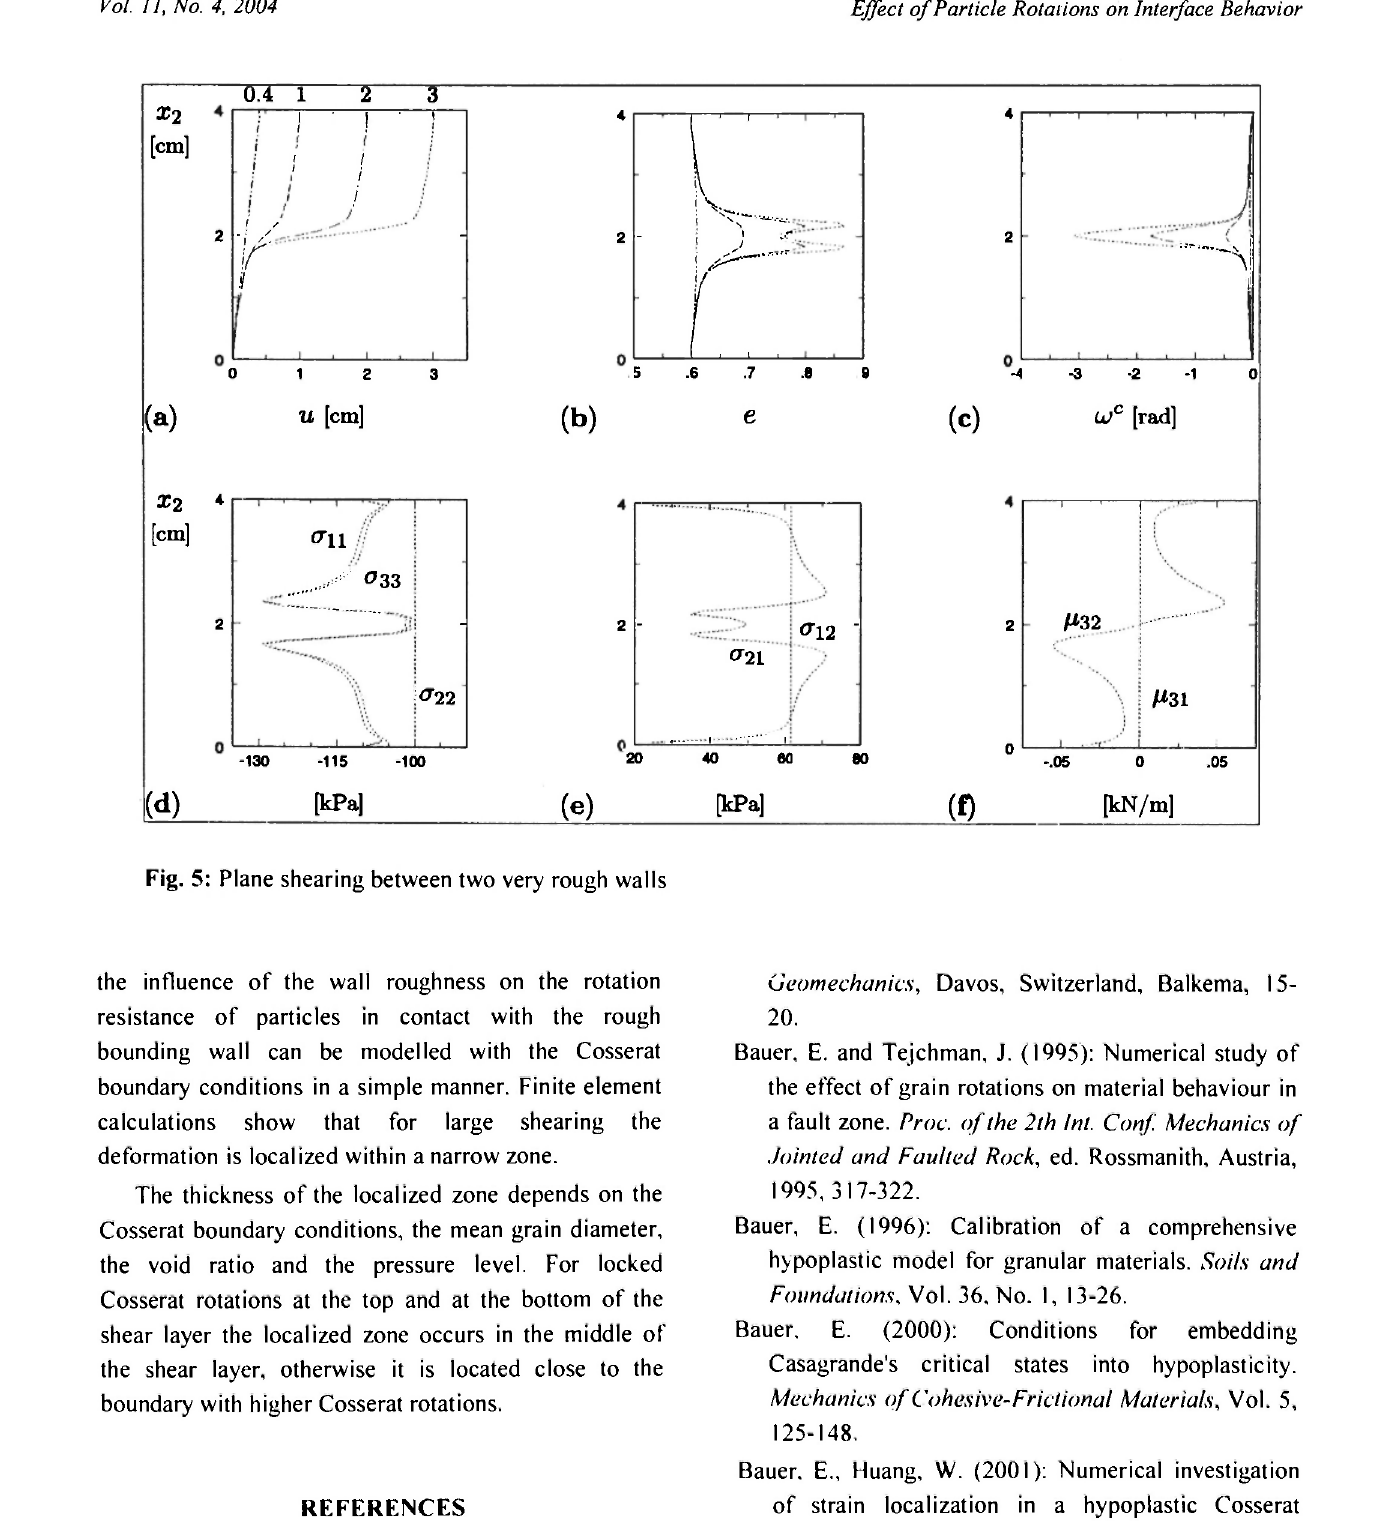
the influence of the wall roughness on the rotation resistance of particles in contact with the rough bounding wall can be modelled with the Cosserat boundary conditions in a simple manner. Finite element calculations show that for large shearing the deformation is localized within a narrow zone. The thickness of the localized zone depends on the Cosserat boundary conditions, the mean grain diameter, the void ratio and the pressure level. For locked Cosserat rotations at the top and at the bottom of the shear layer the localized zone occurs in the middle of the shear layer, otherwise it is located close to the boundary with higher Cosserat